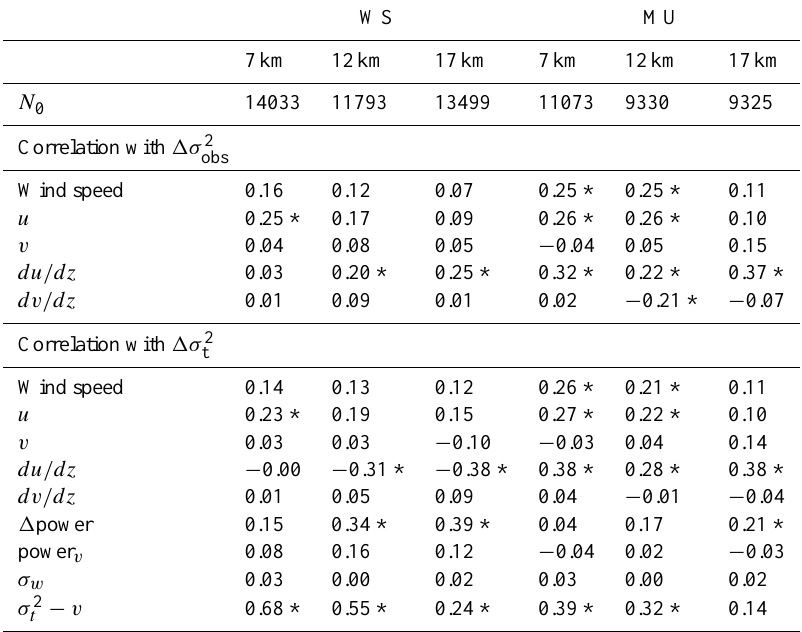
Table 1. Coefficients of correlation of 1σ 2 and 1σ 2 t (meridional plane minus zonal plane) with other variables measured by the VHF obs radars at MU and WS. Correlations of magnitude ≥ 0.2 are flagged with a star